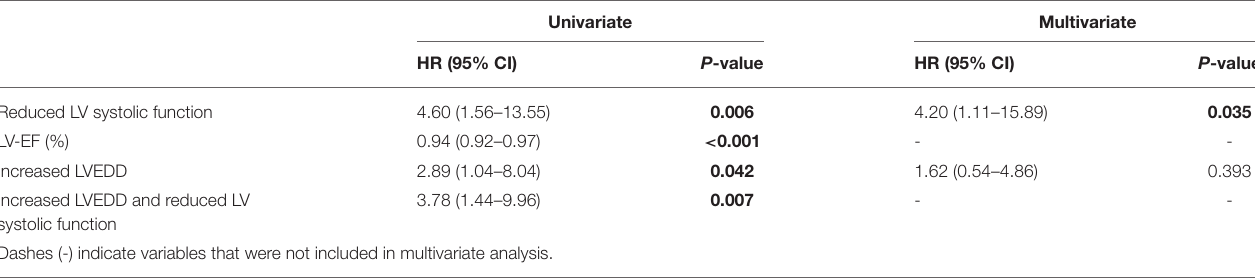
TABLE 4 | Risk for